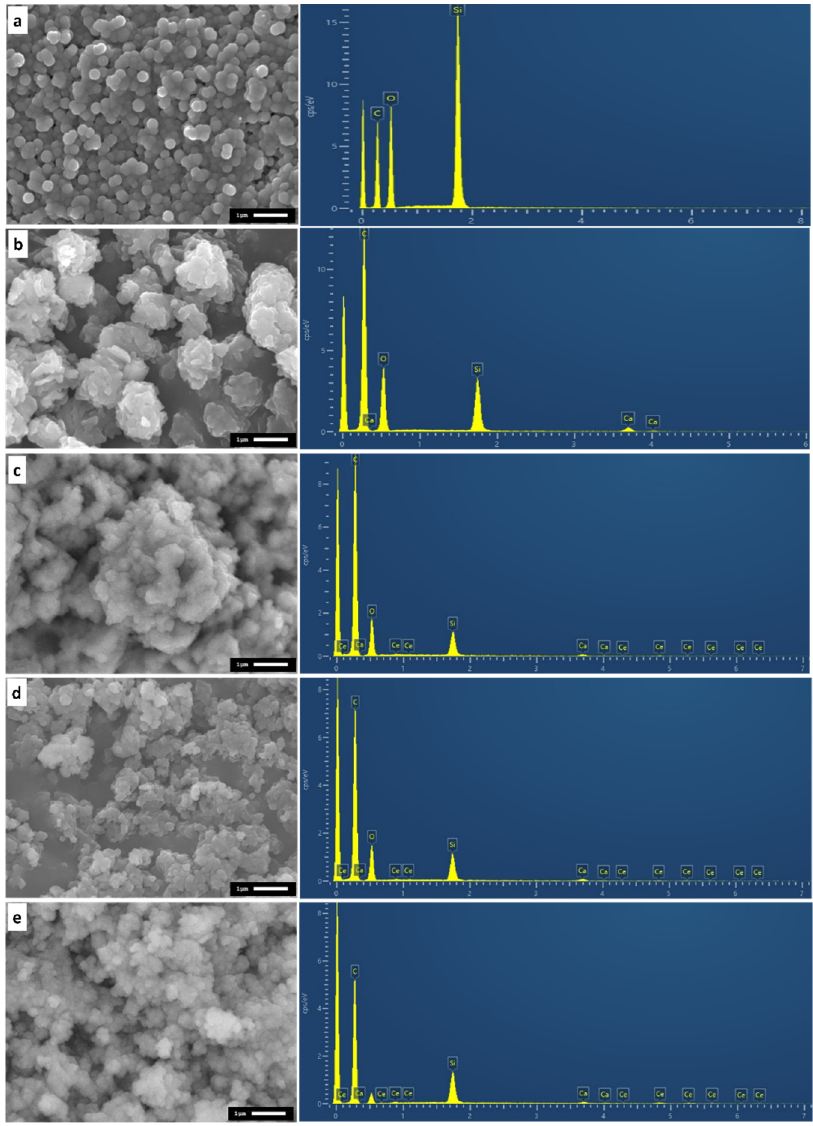
Figure 1. Representative SEM micrographs of the synthesized mesoporous nanopowders. ( a ) Si-NP, ( b ) SiCa-NP, ( c ) SiCaCe1-NP, ( d ) SiCaCe2.5-NP, ( e ) SiCaCe5-NP.